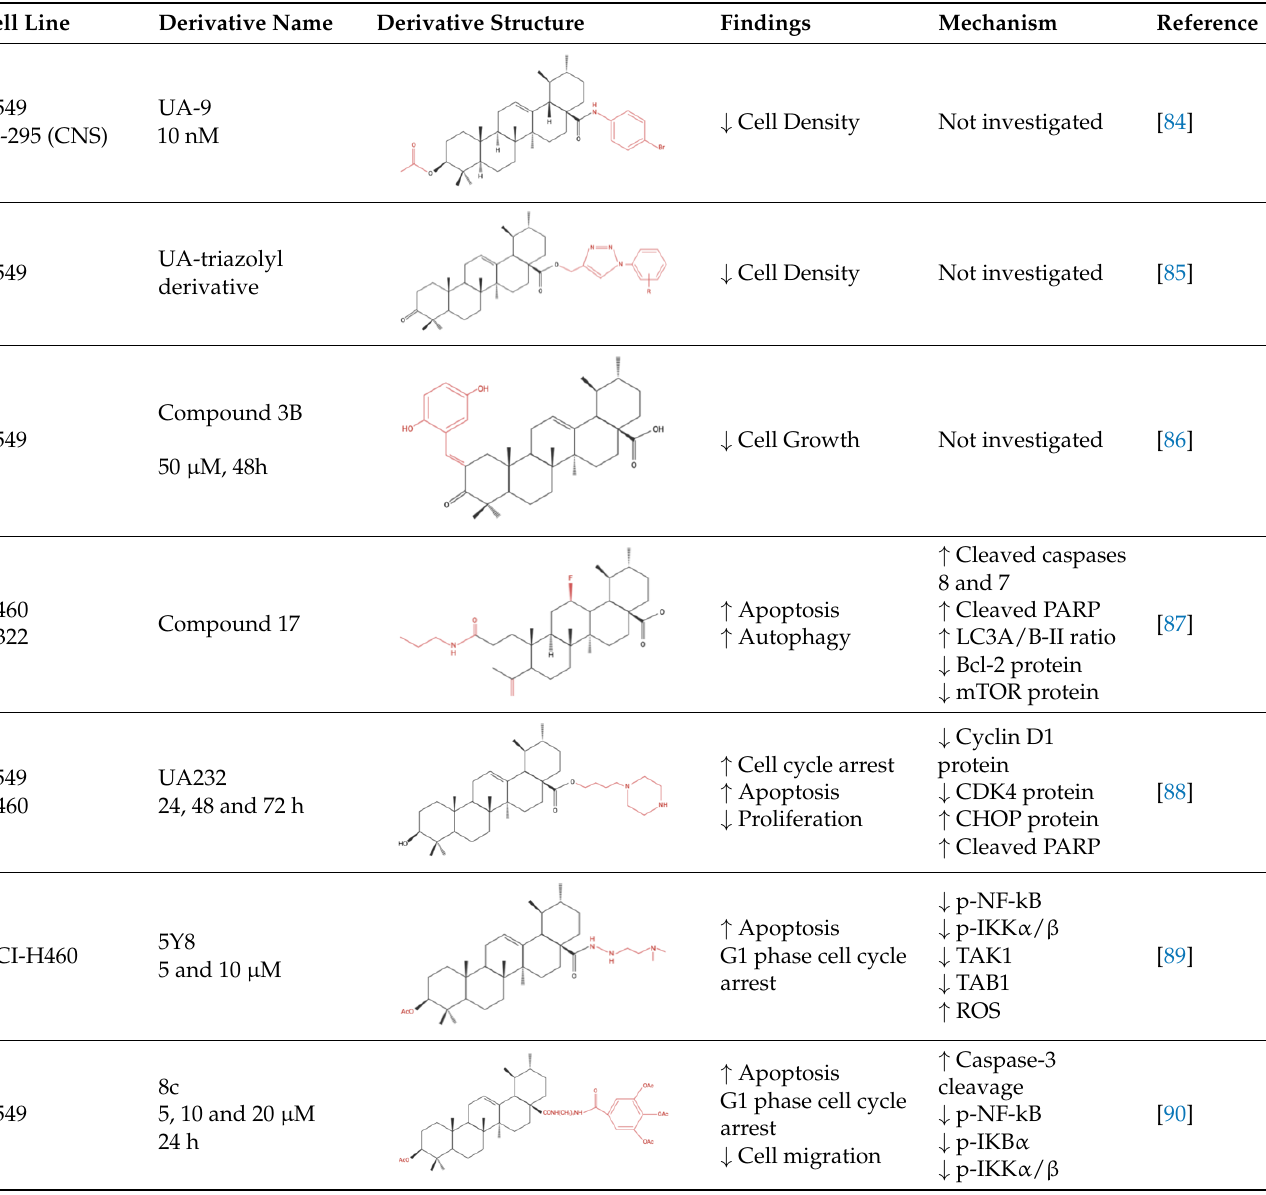
Table 4. Ursolic acid derivatives and their effect against lung cancer in vitro. Chemical structures created with BioRender.com (accessed on 9 September 2022). Black portions indicate parent UA structure, and red segments indicate modifications.